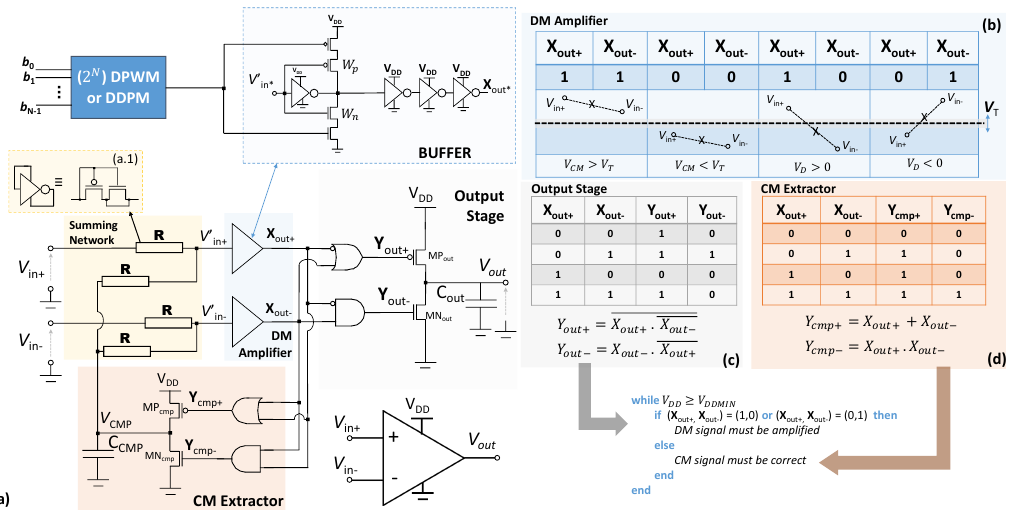
Figure 2. ( a ) ULV DB-OTA schematic ( b ) DM Amplifier analog input voltage tracking ( c ) output stage Boolean equations ( d ) CM extractor Boolean